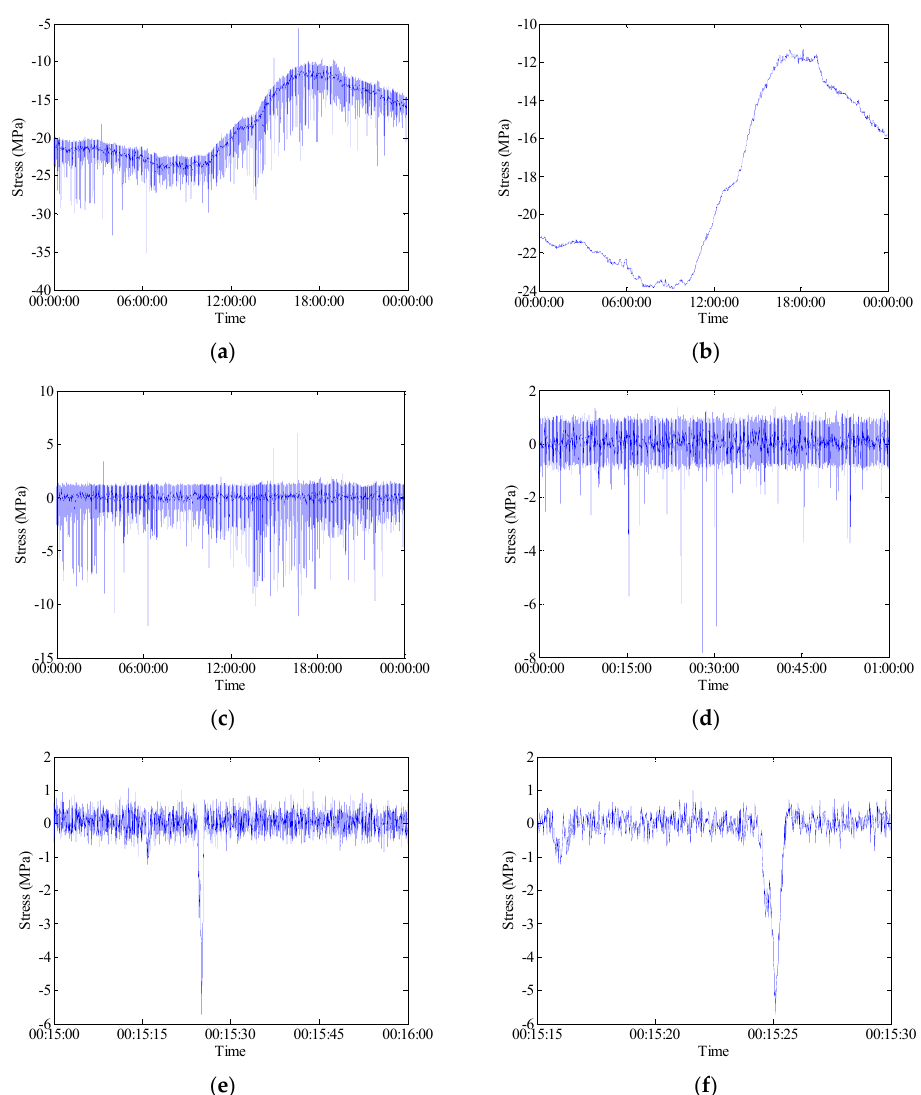
Figure 9. Raw data measured by FBG-MS-NS-2-2: ( a ) Stress time history; ( b ) Temperature time history; ( c ) Live-load induced history ( d ) Live-load induced stress time history in 1 h; ( e ) Live-load induced stress time history in 1 min; ( f ) Live-load induced stress time history in 15 s.